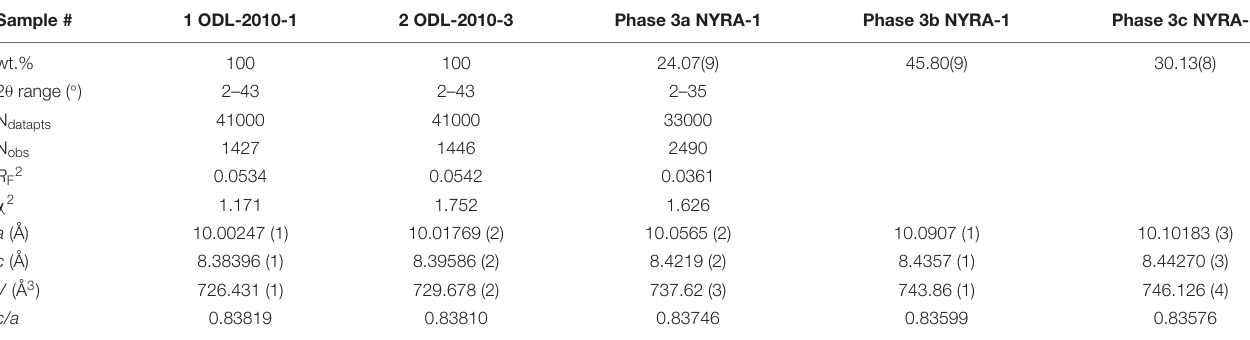
TABLE 2 | Unit-cell and Rietveld refinement parameters for three nepheline